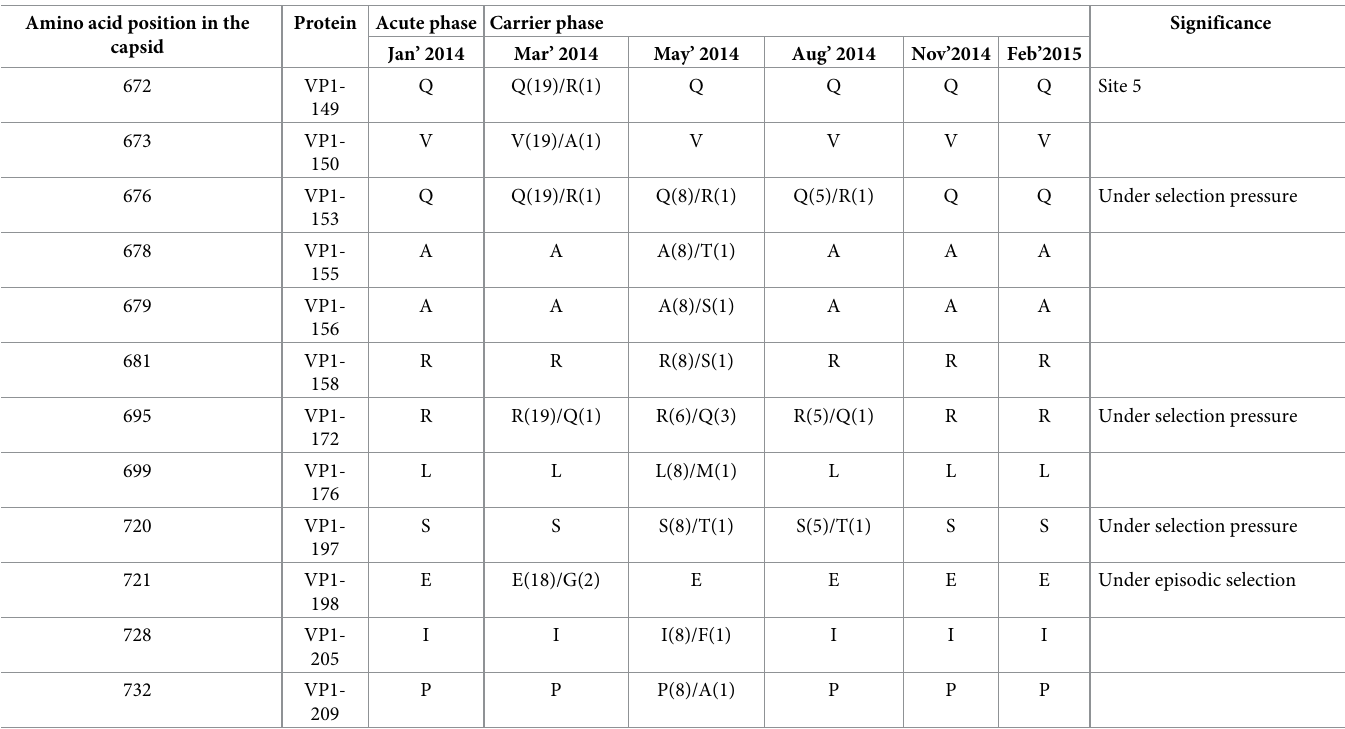
Evolutionary rate in the P1coding region of FMDV carrier isolates Enforced strict and relaxed (Log-normal and Exponential) molecular clocks were used in order to determine the evolutionary rate in the P1 segment of carrier viruses. The Bayes Factor analysis favoured the relaxed log-normal clock. Using the relaxed log-normal clock model, the mean nucleotide substitution was estimated at 1.816 x 10 − 2 substitution/site/year (s/s/y) with a cating significant rate heterogeneity among branches, and supporting the use of the relaxed clock model. The average mutation rate of codon positions 1+2 and 3 was estimated to be 0.519 and 1.963, respectively, indicating a higher contribution of synonymous mutations to the mean evolutionary rate and suggesting the existence of strong constraints for fixation of non-synonymous amino acid mutations due to the need to maintain the functional FMDV capsid structure.